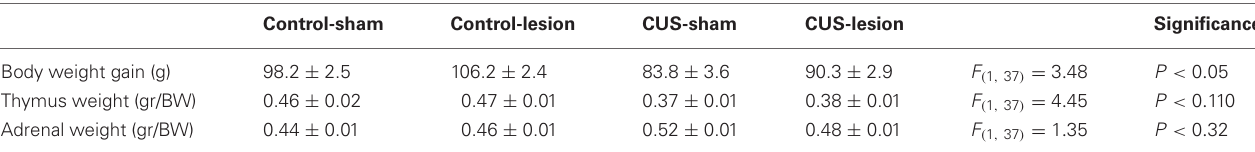
Table 1 | Biometric markers revealed that the CUS protocol decreased body-weight